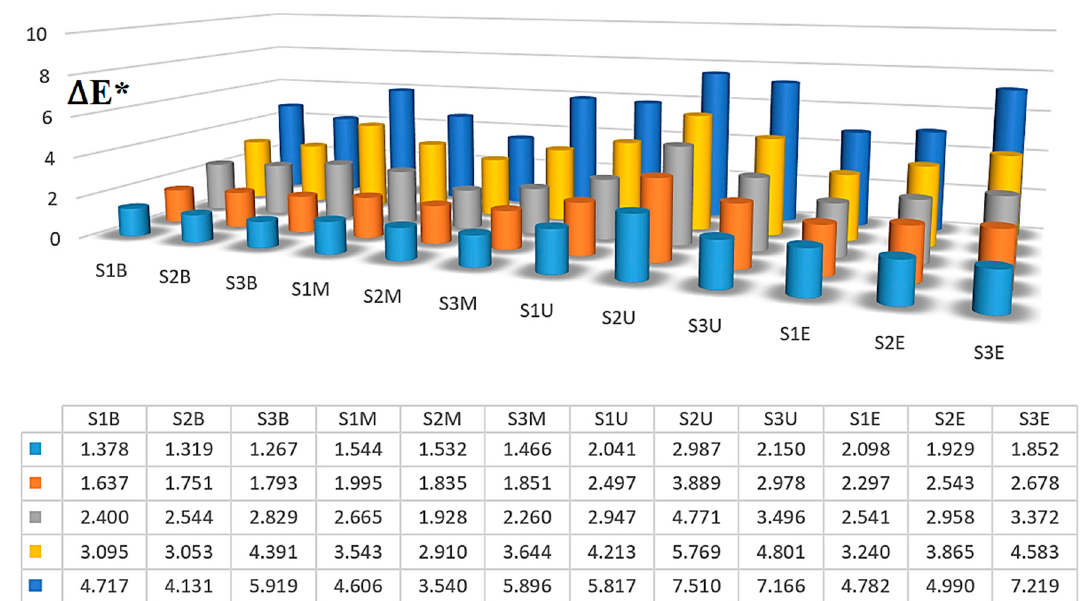
Figure 9. CIEL*a*b* colorimetry with the extracts obtained by boiling (S1B-S3B), microwave (S1M-S3M), ultrasound (S1U-S3U) and at room temperature (S1E-S3E).